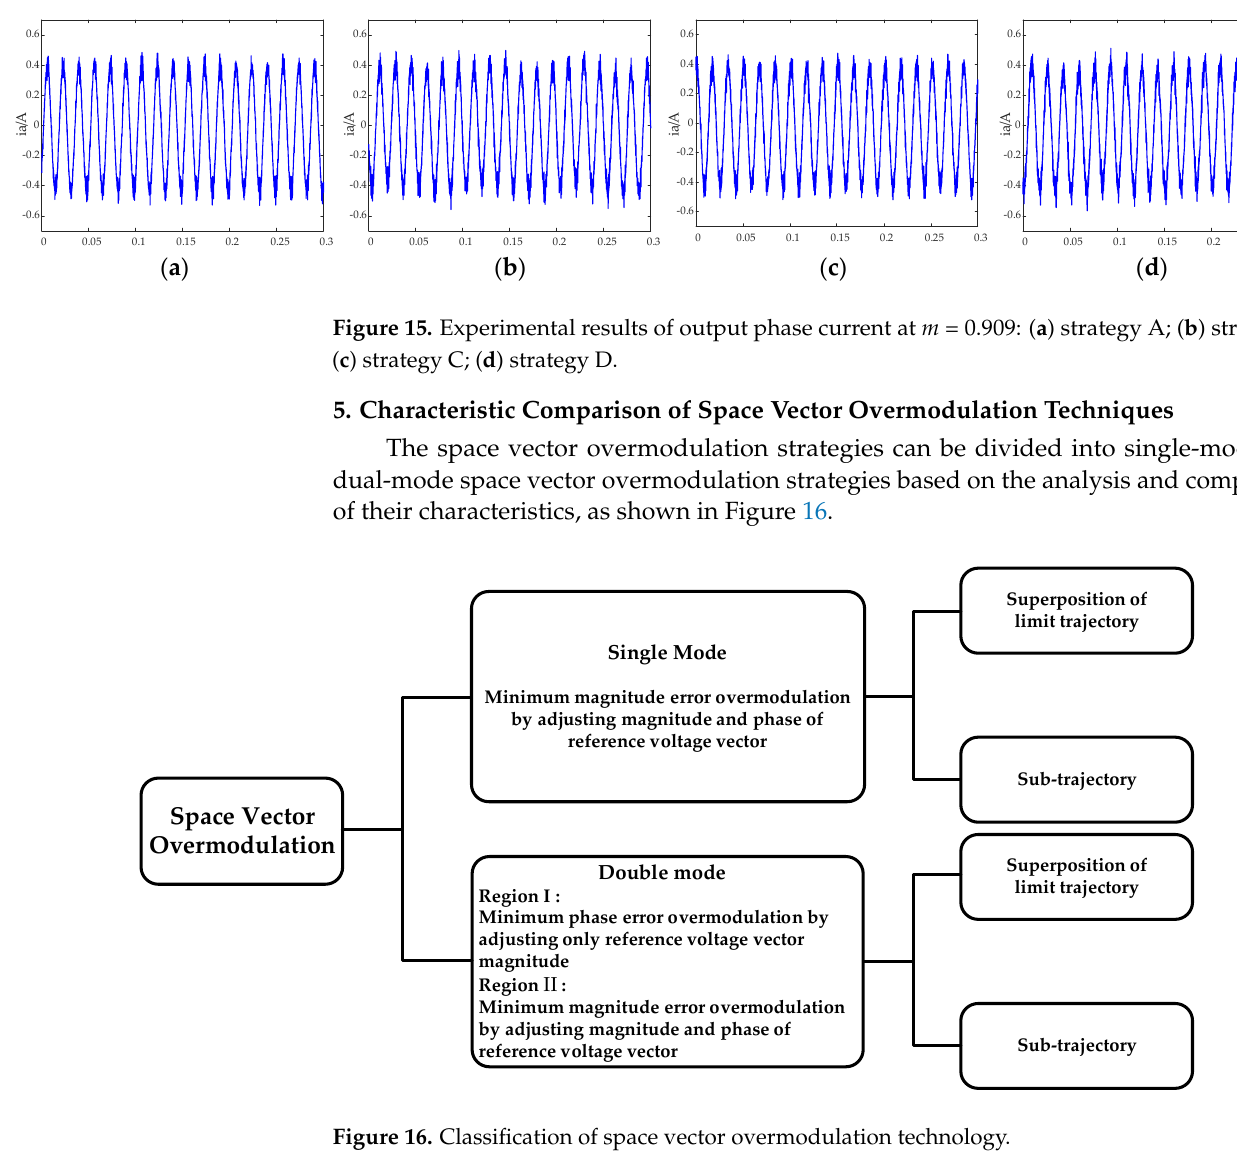
Figure 14. Experimental results of low ‐ order harmonic components: ( a ) 5th; ( b ) 7th.